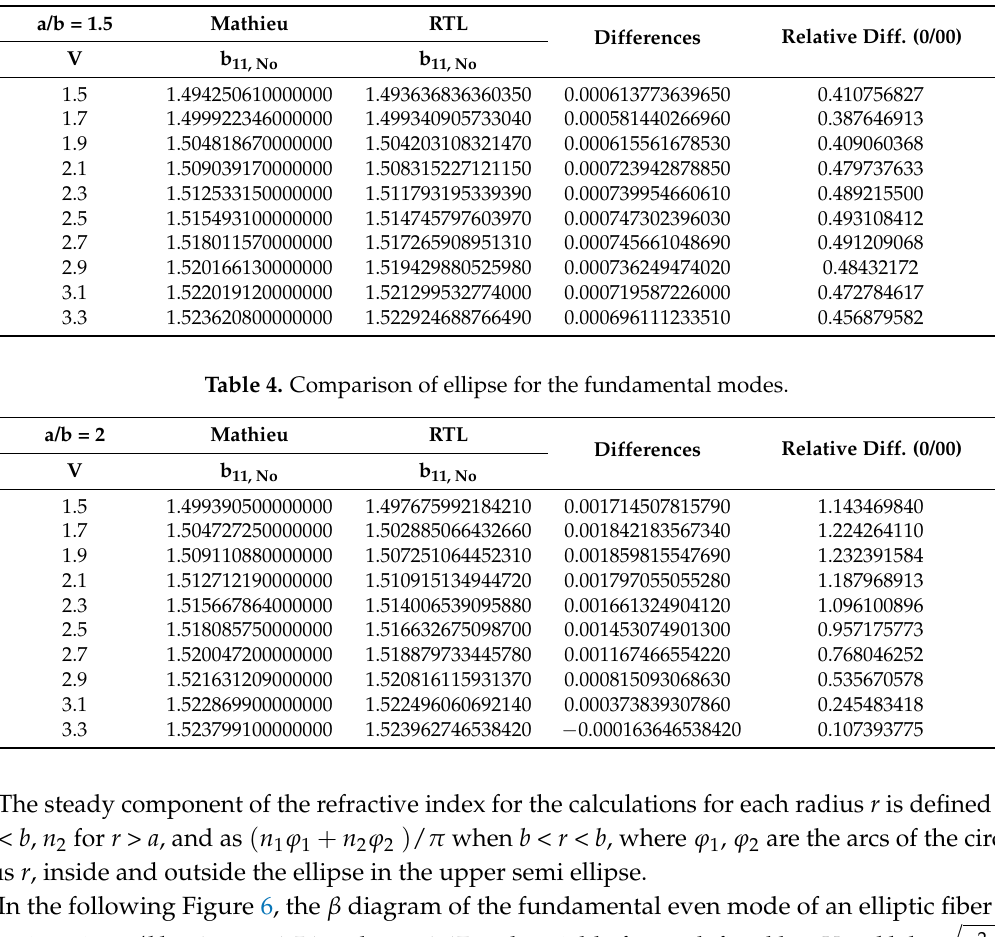
Table 3. Comparison of ellipse for the fundamental modes.